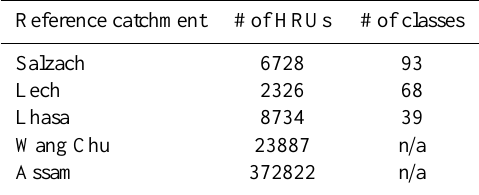
Table 9. Number of HRUs delineated and the number of classes produced in all reference